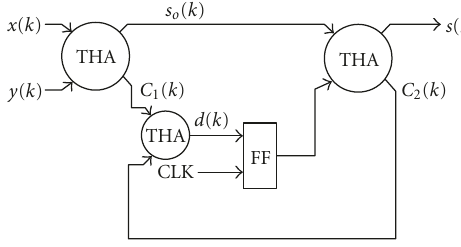
Figure 2: An improved version of the proposed adder (TA) constructed using three ternary half-adders